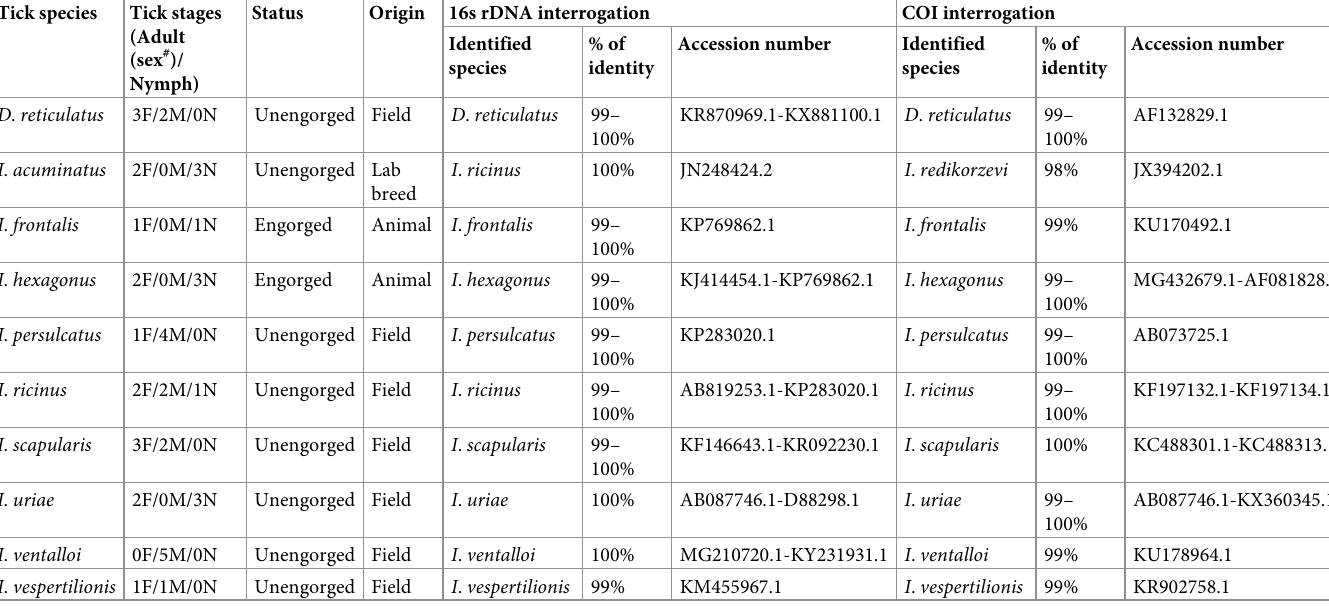
Table 2. Details of the 44 specimens included in the reference database and homology to the reference sequences using